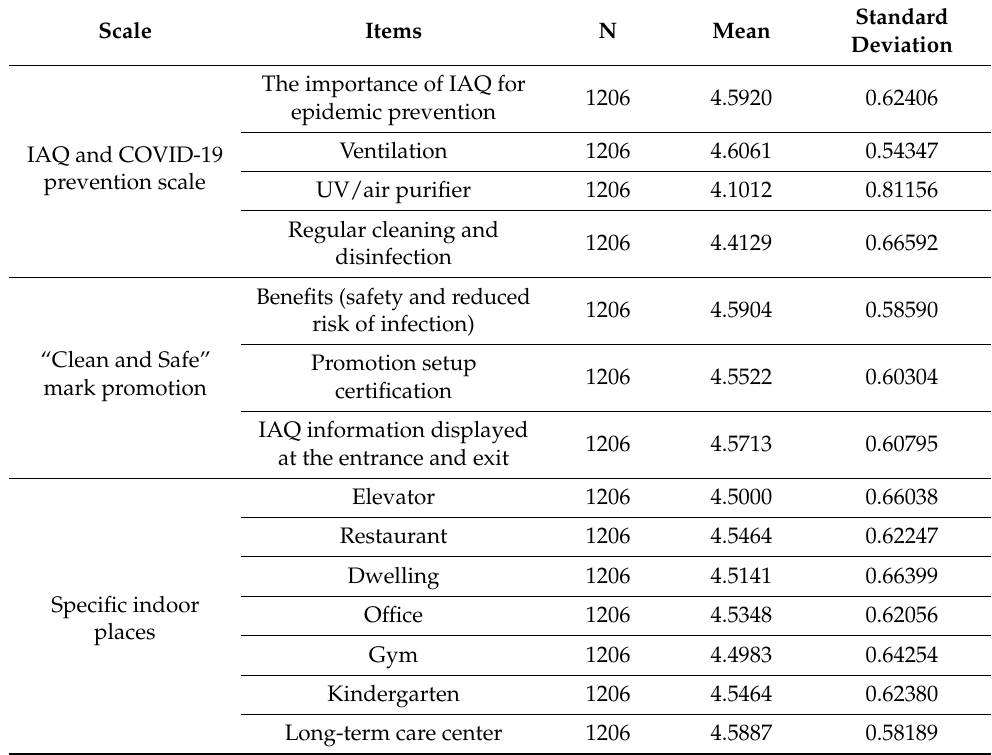
Table 7. The descriptive statistics of